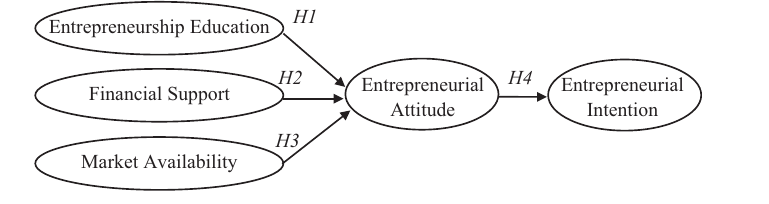
Figure 1. Research